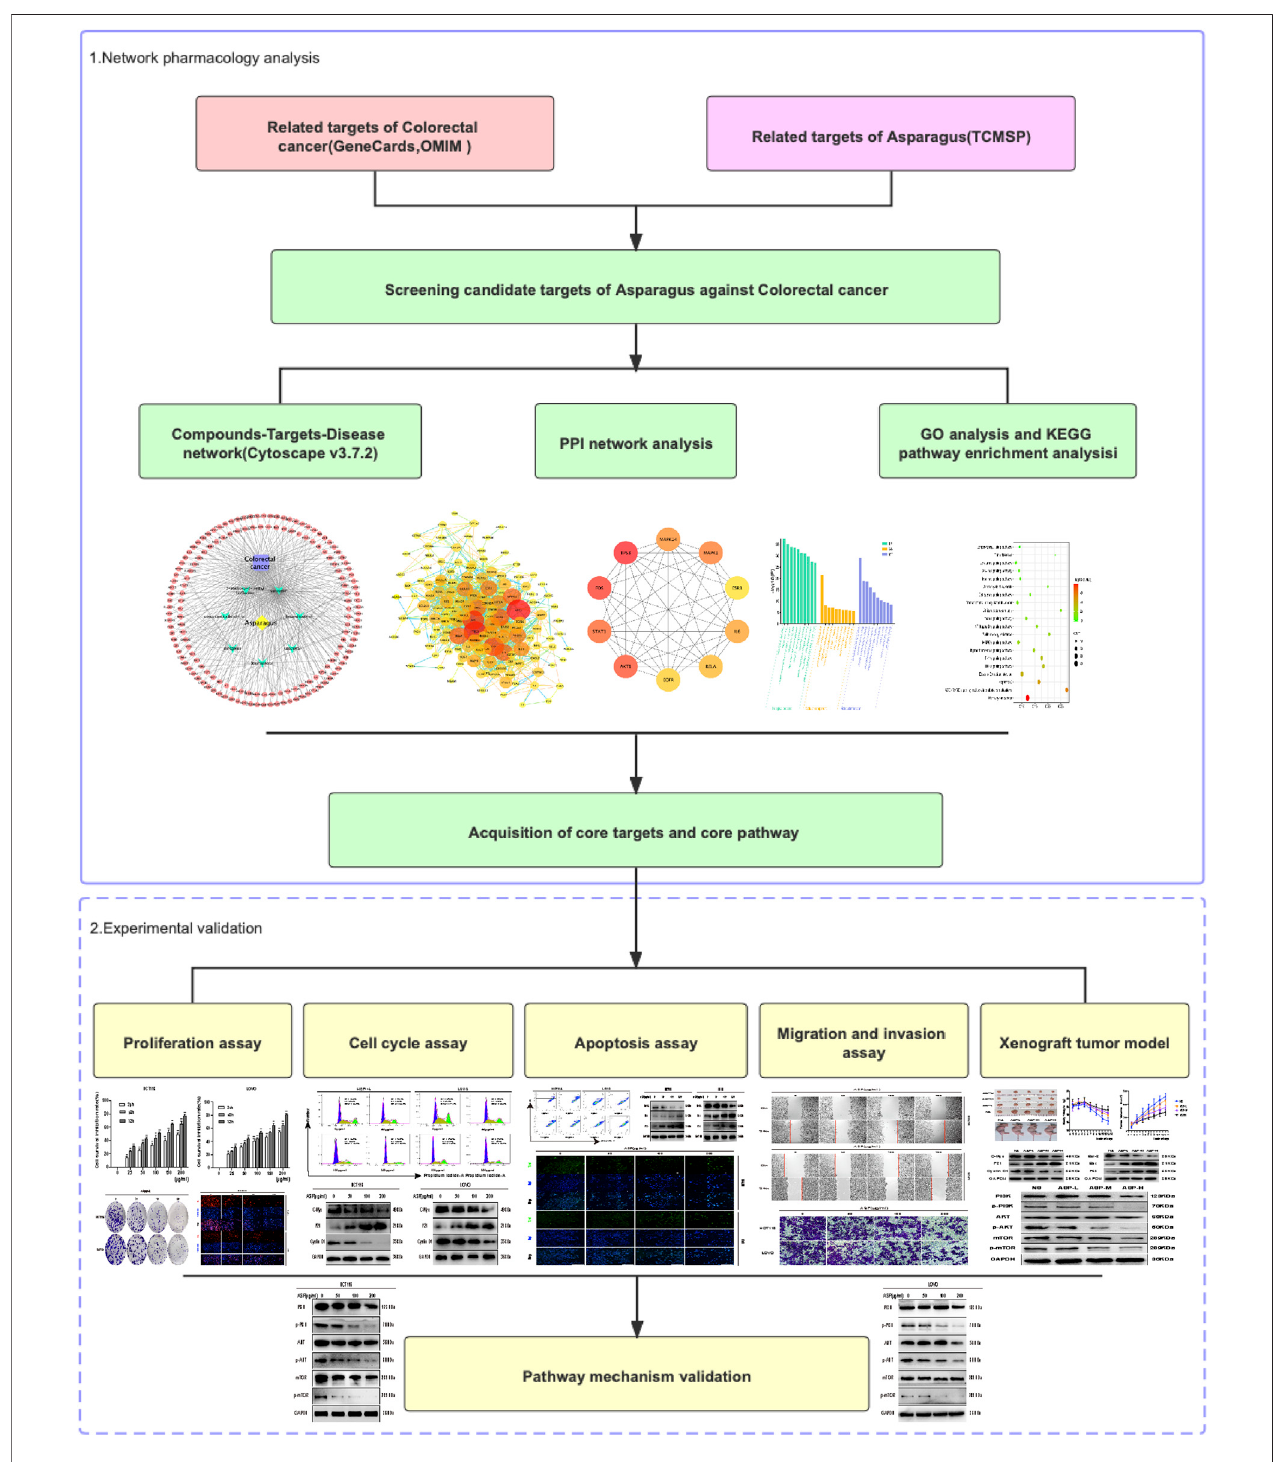
FIGURE 1 | The work fl ow of the network pharmacology analysis and validation of ASP against CRC.